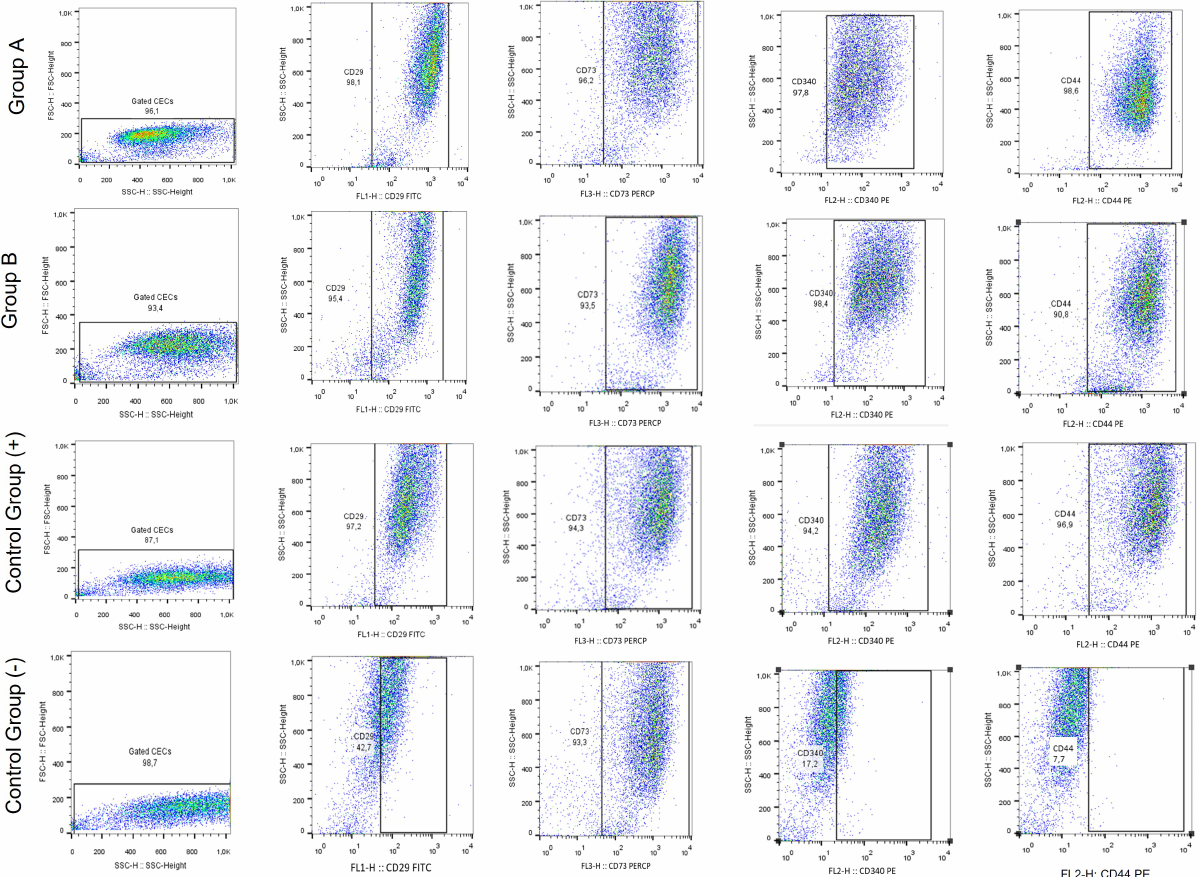
Figure 5. Flow cytometric analysis of CECs. CECs of all groups were examined for the expression of CD29, CD73, CD340, and CD44. Initially, to determine the cellularity and granulation, CECs were evaluated for the parameters of front scatter (FSC) and side scatter (SSC). Then, the CECs were analyzed further for the expression of CD29, CD73, CD340, and CD44. Group A: CECs cultured with α -MEM supplemented with 20% v/v CB-PL), Group B: CECs cultured with α -MEM supplemented with 20% v/v CB-PPP, control group (+): positive control group, CECs cultured with complete culture medium, control group ( − ), negative control group: CECs cultured only with α